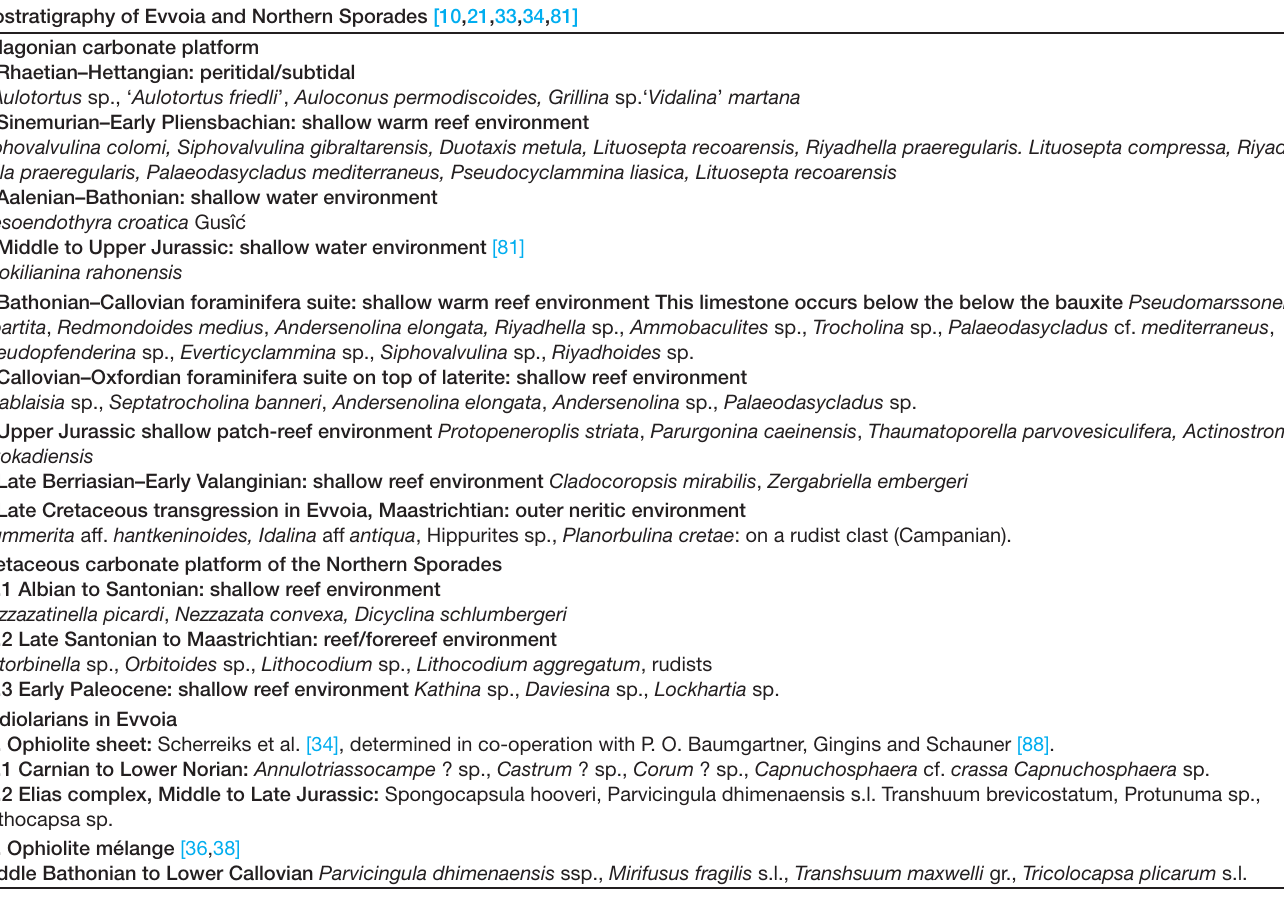
Table 1a. Biostratigraphic data, Evvoia and the Northern Sporades Biostratigraphy of Evvoia and Northern Sporades